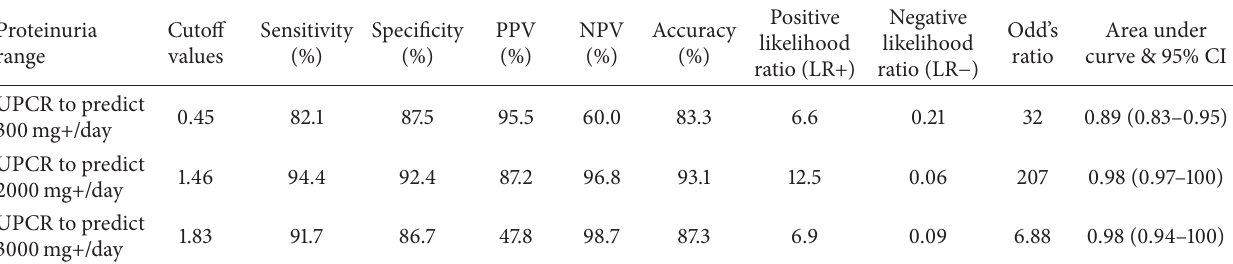
Table 5: Diagnostic ability of urine protein :creatinine Ratio (UPCR) for various proteinuria range.